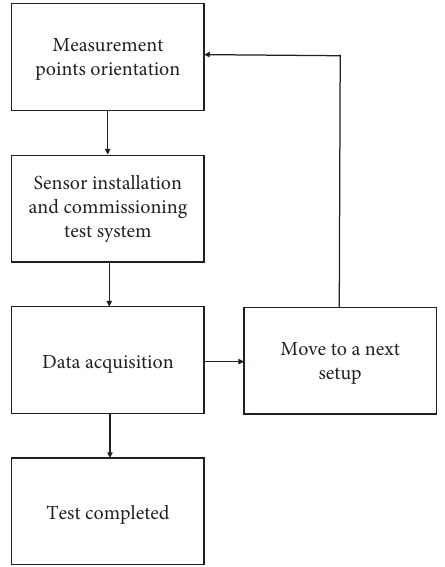
Figure 4: Flow chart of the test